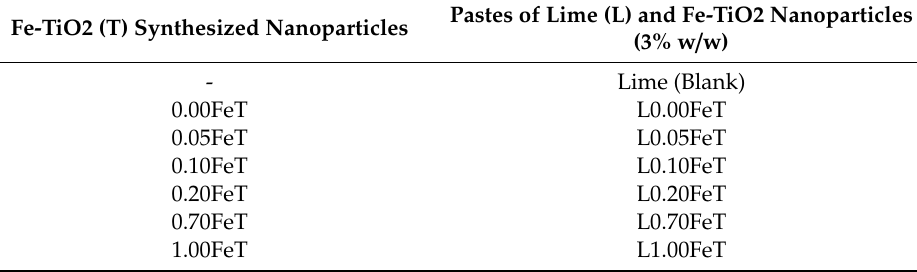
Table 1. Synthesized nanoparticles and lime